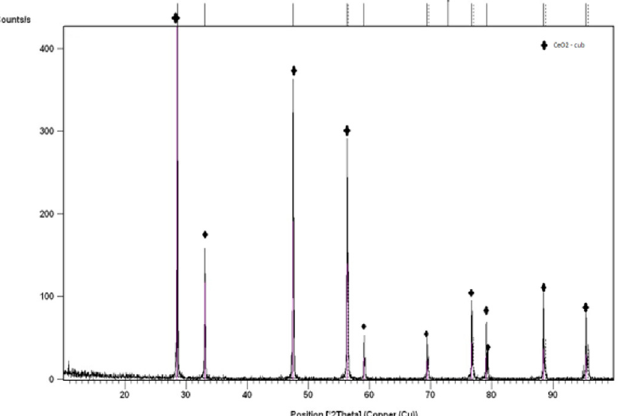
Fig. 6. XRD patterns of nano-SPVD powders of CeO 2 doped with Gd.